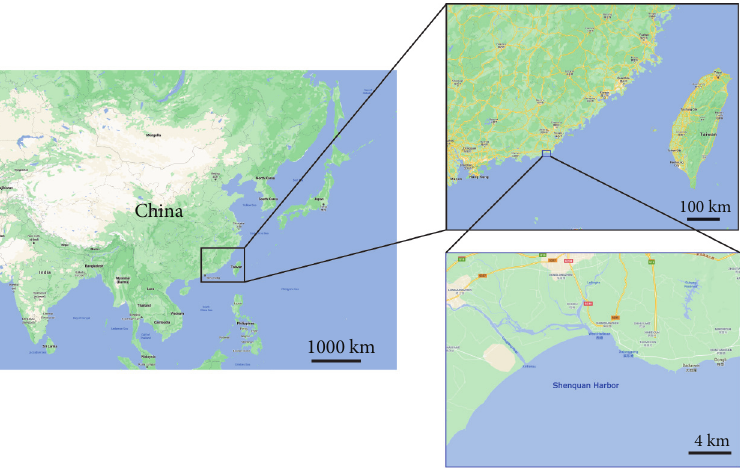
Figure 1: The spatial location of the port of Shenquan and the research